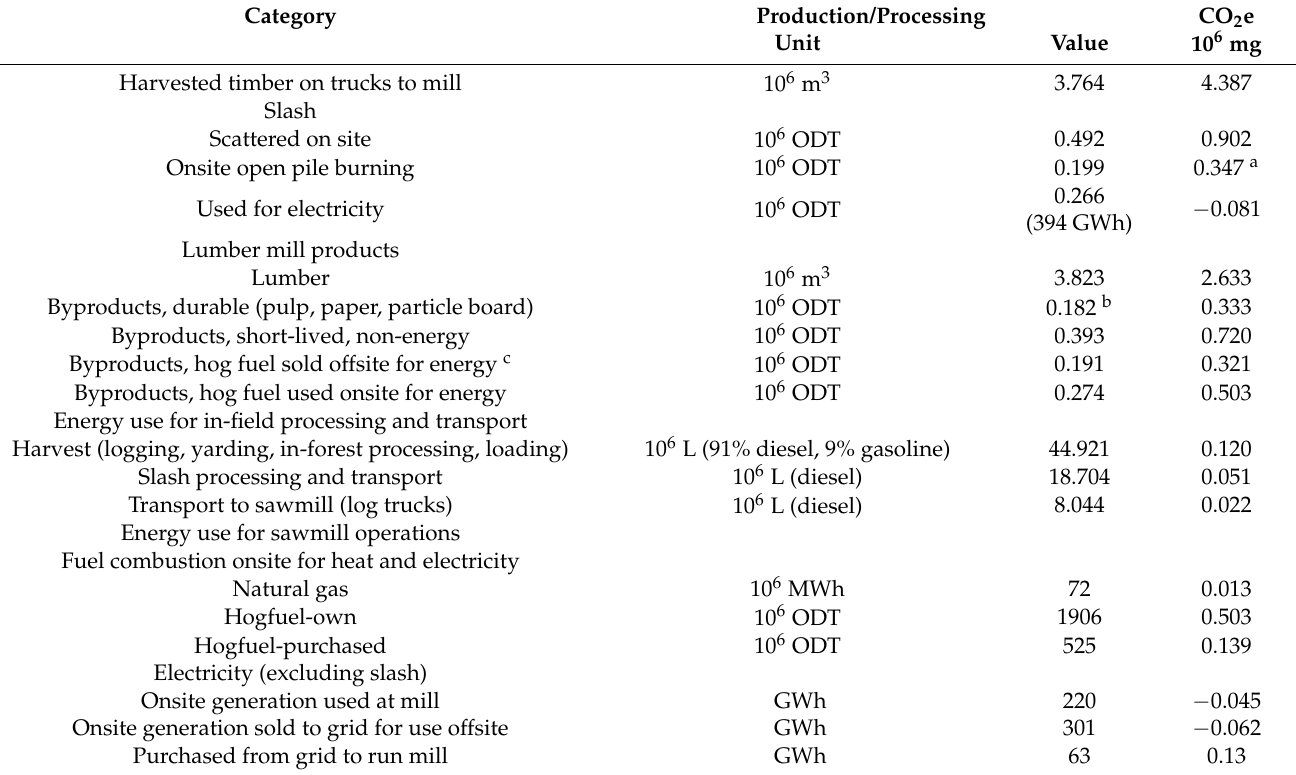
Table 1. Fate and CO 2 profile of sawlogs processed by surveyed entities in 2015. CO 2 volumes stored in wood products do not add exactly to 100% of CO 2 volume of harvested sawlogs due to rounding and minimal reporting inconsistences (4% error). The quantity of CO 2 e is reported in millions of megagrams (10 6 mg). Carbon stocks and GHG emissions are expressed as positive values. GHG emission savings are expressed as negative